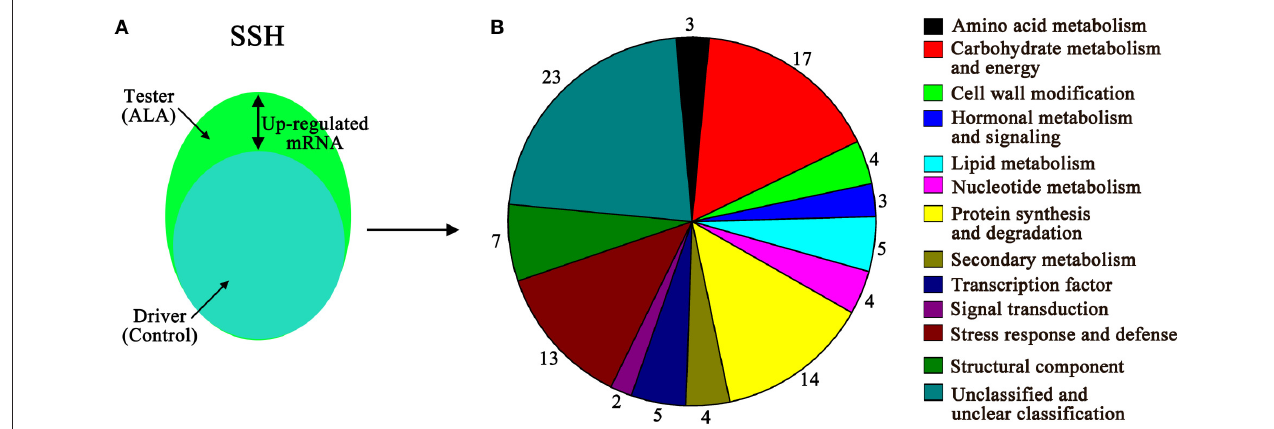
FIGURE 4 | Up-regulated genes in response to ALA treatment were identified by SSH in apple skin. (A) Visual representation of the experimental plot of suppression subtractive hybridization (SSH). Tester, ALA-treated apple skin; driver, water-treated apple skin (control). (B) The function of unigenes from up-regulated genes pool was classified into 13 functional